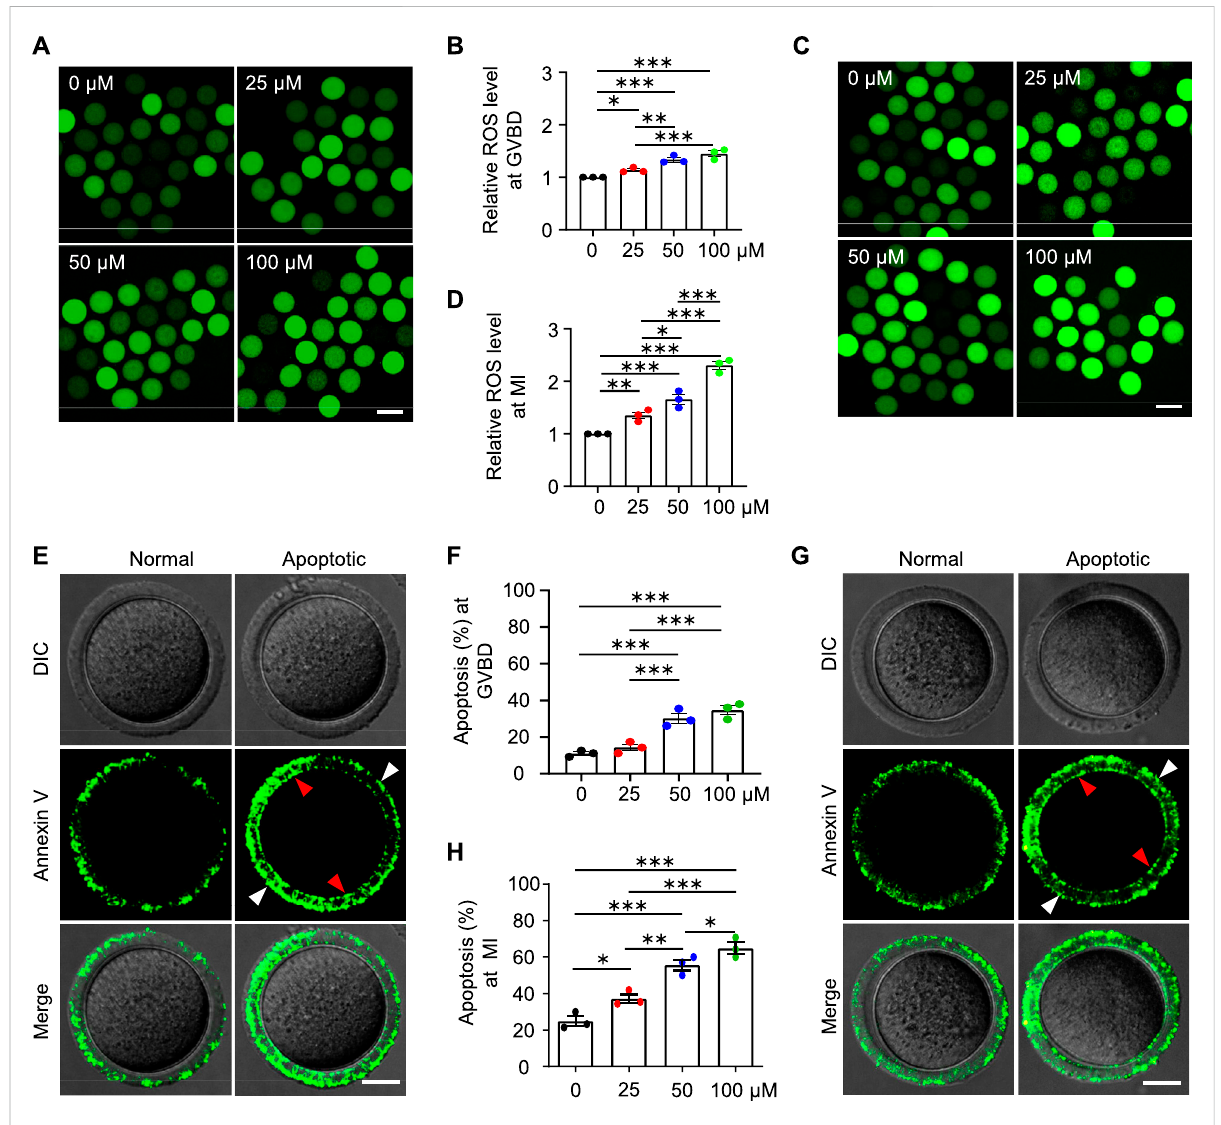
AAI exposure increases intracellular ROS levels and induces early apoptosis in mouse GVBD and MI oocytes. (A – D) The GV oocytes were matured for 2 and 8 h to reach GVBD and MI stage in the M16 medium with 0, 25, 50, and 100 μ M AAI. Oocytes were collected and ROS levels were examined with the reliable DCFH-DA probe. Representative images showing ROS levels in GVBD oocytes (A) . Quanti fi cation of (A) showing the relativeROSlevel (B) .RepresentativeimagesshowingROSlevelsinMIoocytes (C) .Quanti fi cationof (C) showingtherelativeROSlevel (D) .Scale bar, 100 μ m (A,C) . Error bar, mean ± SEM of 3 independent experiments. ~30 oocytes per treatment in each experiment. Totally 96, 74, 86, and 87GVBDoocytesand85,76,90,and71MIoocyteswereusedforeachtreatment,respectively (B,D) .*, p < 0.05;**, p < 0.01;***, p < 0.001;one-way ANOVA and the LSD test (B,D) . (E,G) Representative images showing Annexin V staining of GVBD oocytes (E) or MI oocytes (G) that matured in the M16 medium with indicated AAI concentration. The detection of early apoptosis was performed using FITC conjugated Annexin V. Oocytes with positive Annexin V staining on both zona pellucida (white arrowheads) and cytoplasmic membrane (red arrowheads) were considered early apoptosis. Scalebar,20 μ m (E,G) . (F,H) Quanti fi cationof (E,G) showingtheratesofearlyapoptoticoocytes.Error bar, mean±SEM of3independent experiments.25 – 30oocytes per treatment ineach experiment. Totally, 73,85,85, 81 GVBDoocytesand 88, 91,70, and 77 MIoocyteswereused for each treatment, respectively (F,H) . Only comparisons with signi fi cant differences were indicated; *, p < 0.05; **, p < 0.01; ***, p < 0.001; one-way ANOVA and the LSD test (F,H)